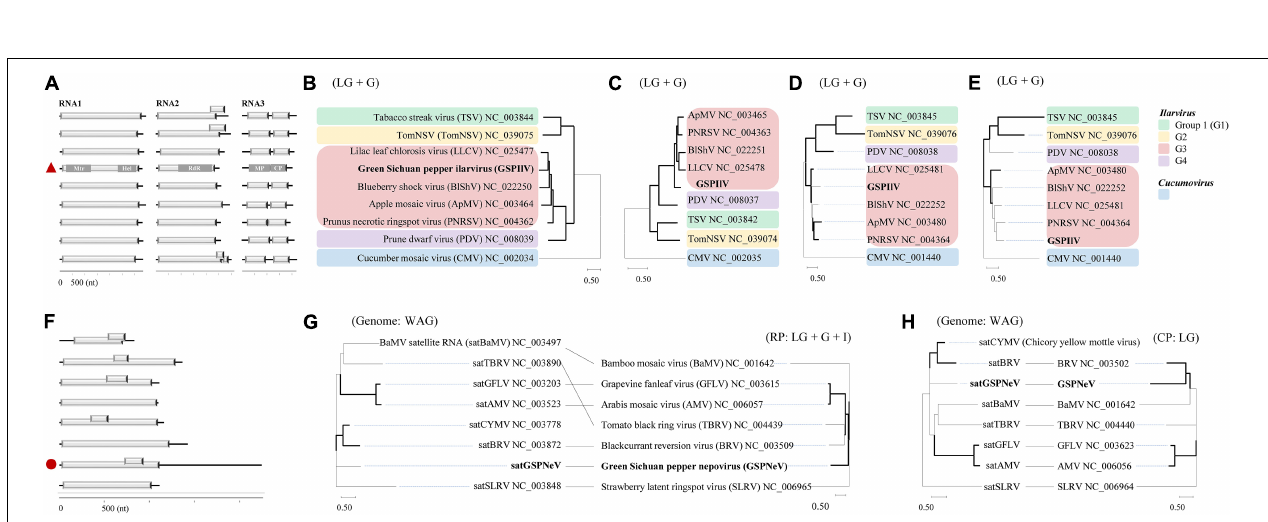
FIGURE 2 | Sequence and phylogenetic characteristics of green Sichuan pepper-ilarvirus (GSPIlV) and green Sichuan pepper-nepovirus large linear satellite RNA (satGSPNeV). Genomic comparisons of GSPIlV (the red triangle) and ilarviruses (A) . Mtr, methyltransferase; Hel, helicase; MP, movement protein; CP, coat protein. Phylogenetic relationships of GSPIlV and ilarviruses inferred from alignments of replicase (RP, B ), RNA-dependent RNA polymerase (C) , MP (D) , and CP (E) sequences; cucumber mosaic virus (CMV) was used as an outgroup. RNA structure of satGSPNeV ( F , the red circle). Phylogenetic trees and co-evolution analyses of satellite RNAs ( G,H , left) and their helper viruses ( G,H , right) based on satellite nucleotide sequences and helper virus RPs ( G , right) and ( H , right). The models in MEGA-X selected for phylogenies are indicated. The nodes with > 50% bootstrap supports are shown by thick lines.